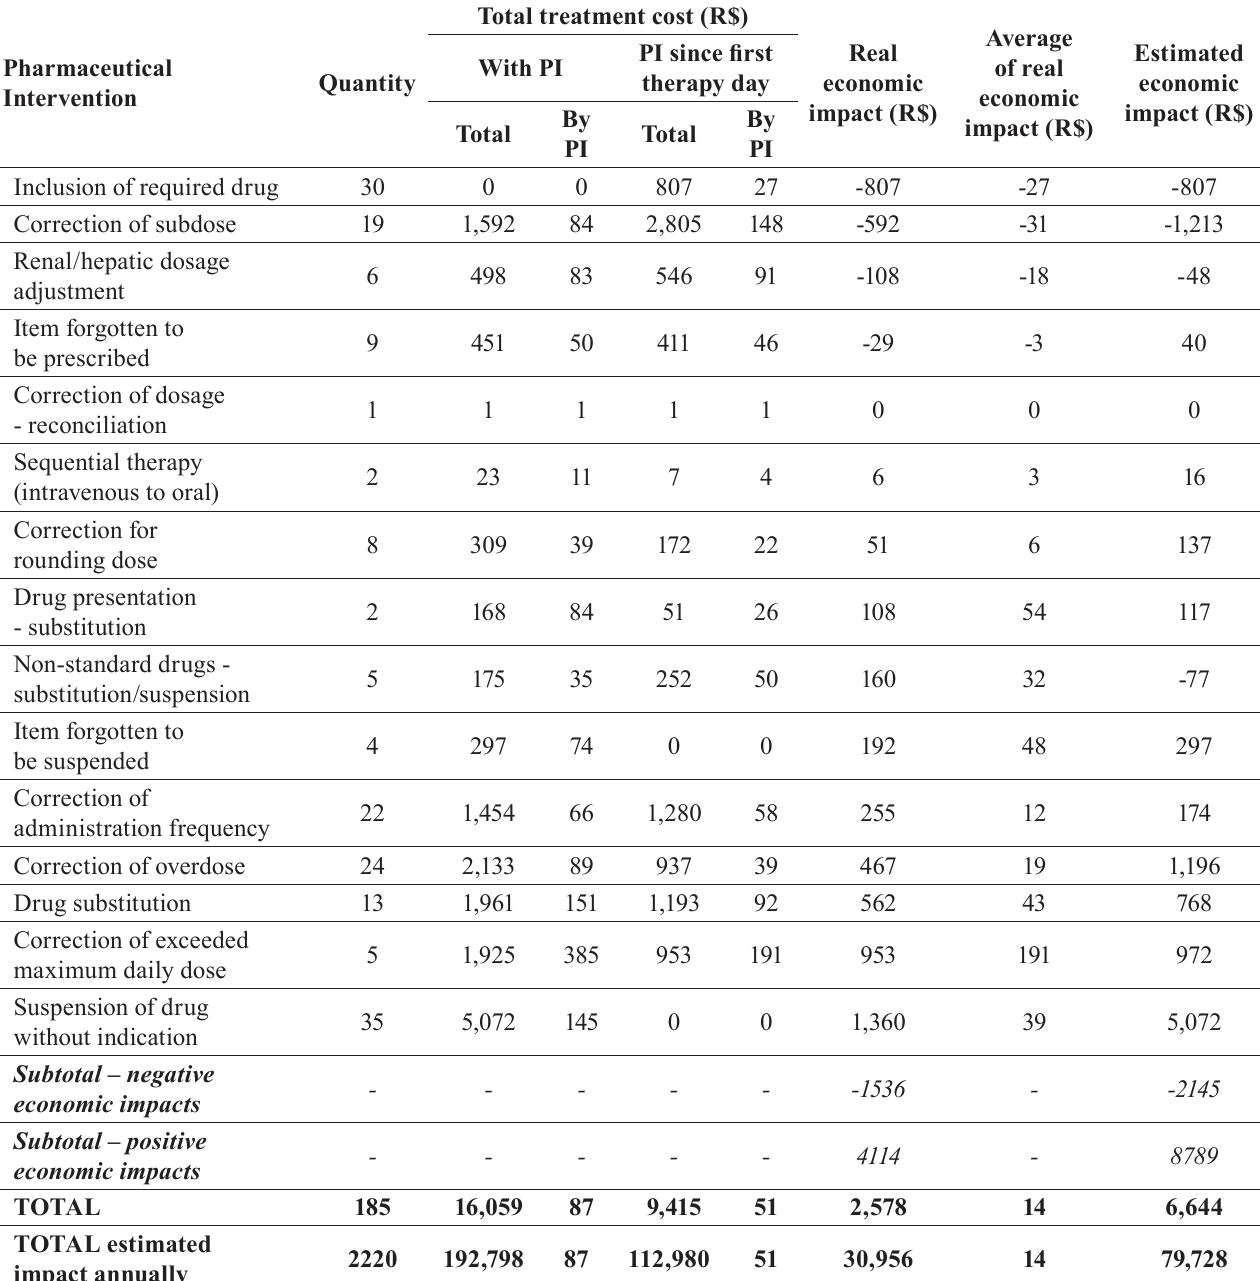
TABLE II - Economic impact analysis by pharmaceutical intervention